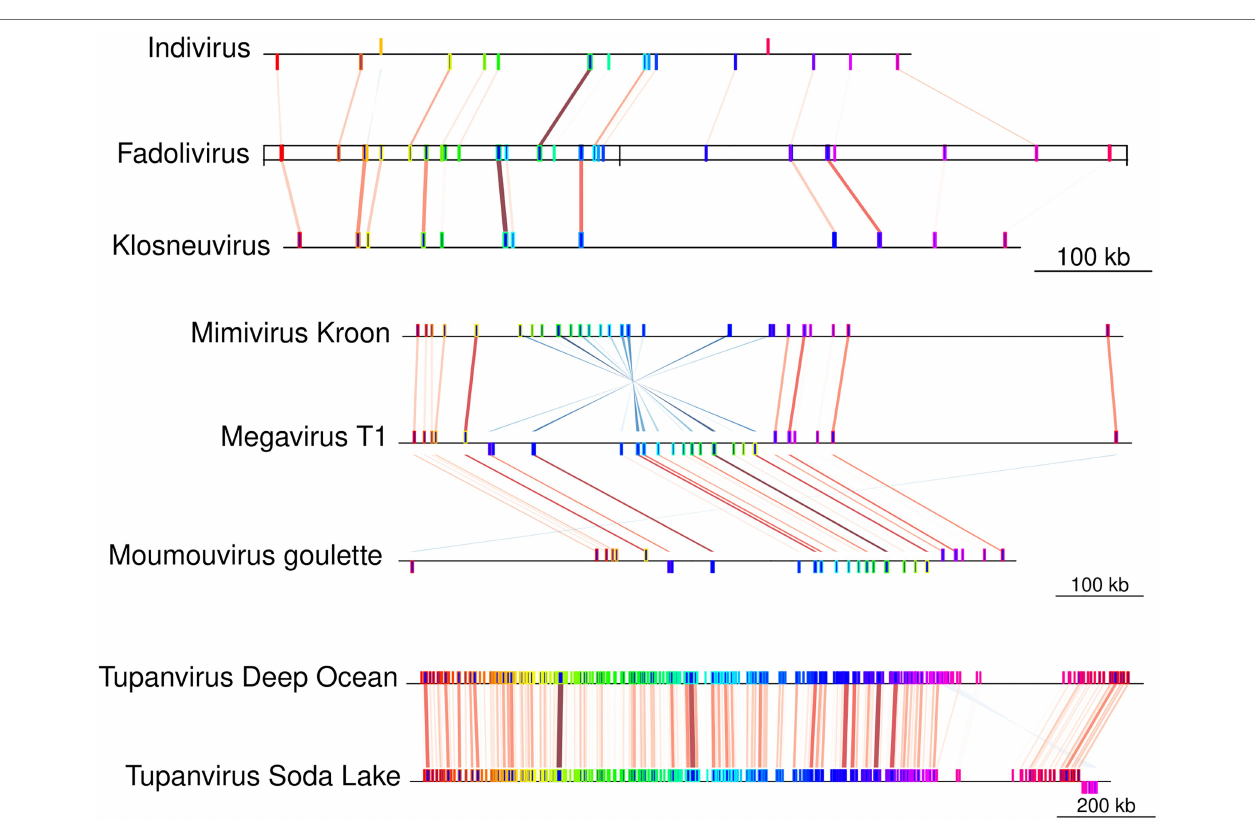
FIGURE 3 | Block synteny comparison between Fadolivirus and other Klosneuvirinae genomes. Conserved genomic regions (Mauve conserved blocks) between Fadolivirus and its closest relatives, Klosneuvirus and Indivirus. Contigs in Indivirus and Klosneuvirus have been reordered based on the Fadolivirus genome. For comparison, conserved regions are also shown between selected members of the proposed subfamily Megamimivirinae, including